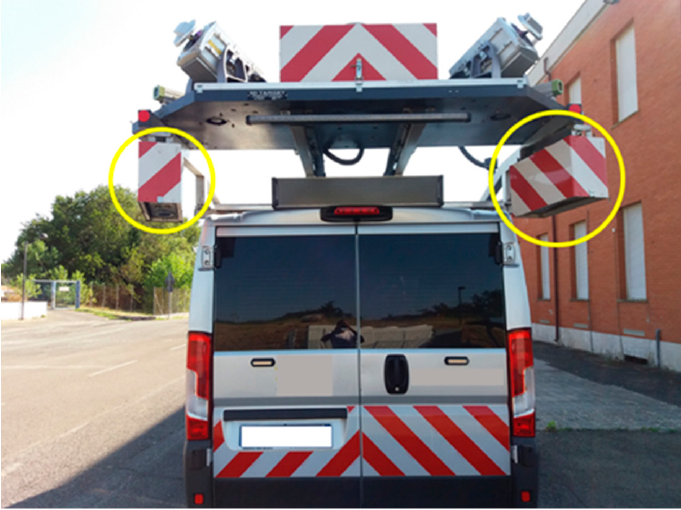
Figure 2. LCMS sensors installed on the surveying vehicle.